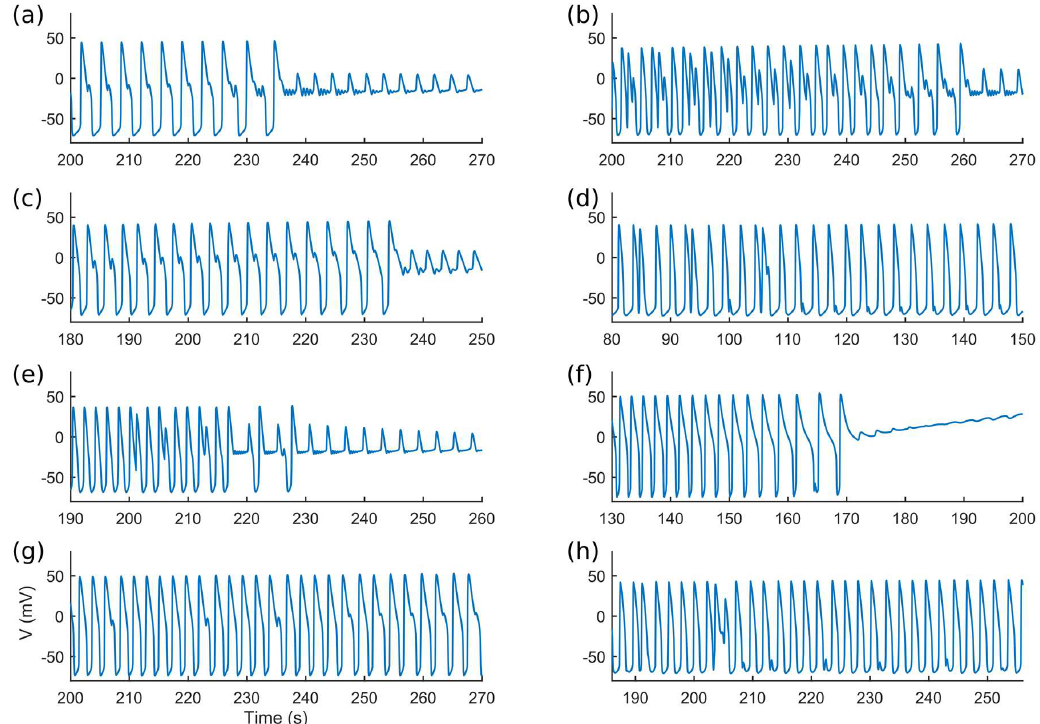
Figure 12. Abnormalities induced by quinidine. ( a ) Single and multiple EADs and repolarization failure. ( b ) Single and multiple EADs and repolarization failure. ( c ) Single EADs and repolarization failure. ( d ) Anticipated APs, EADs and DAD-like abnormalities. ( e ) Multiple EADs and repolarization failure. ( f ) Repolarization failure. ( g ) Single EADs. ( h ) Anticipated APs, EADs and DAD-like abnormalities.